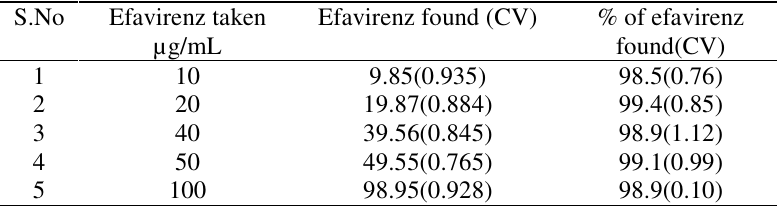
Table 3 . Efavirenz estimation in bulk by proposed method.